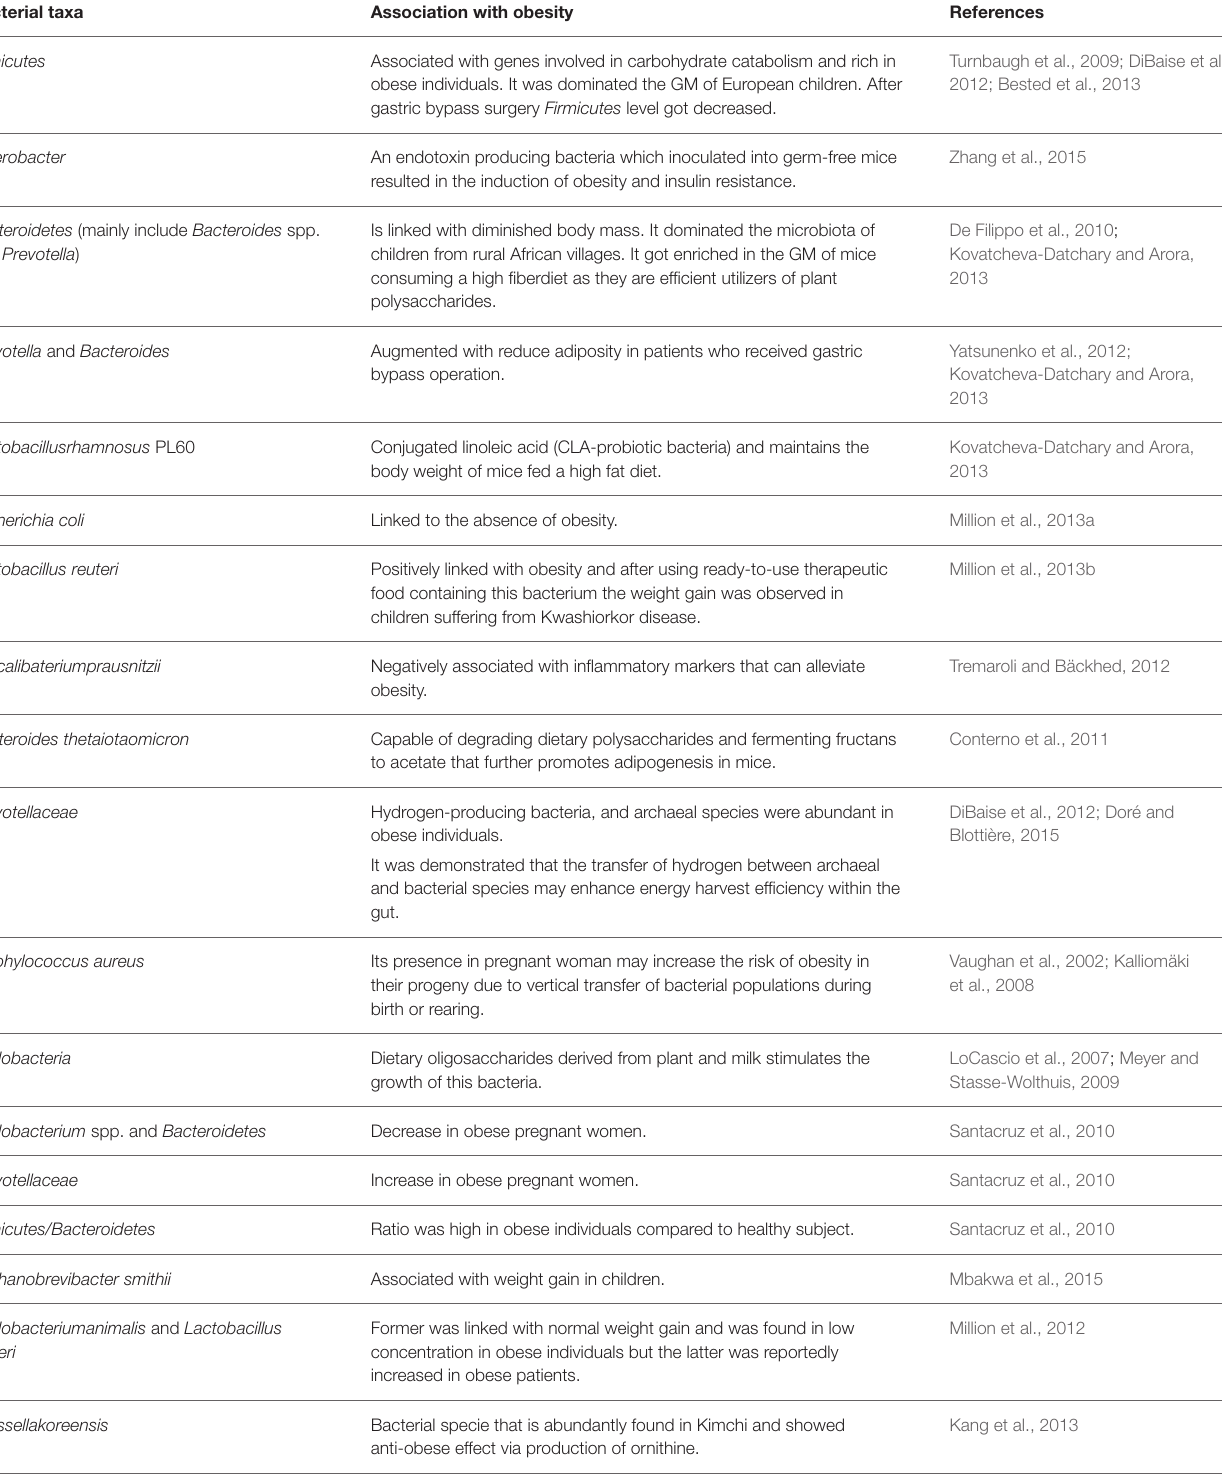
TABLE 1 | List of some bacterial taxa and their association with